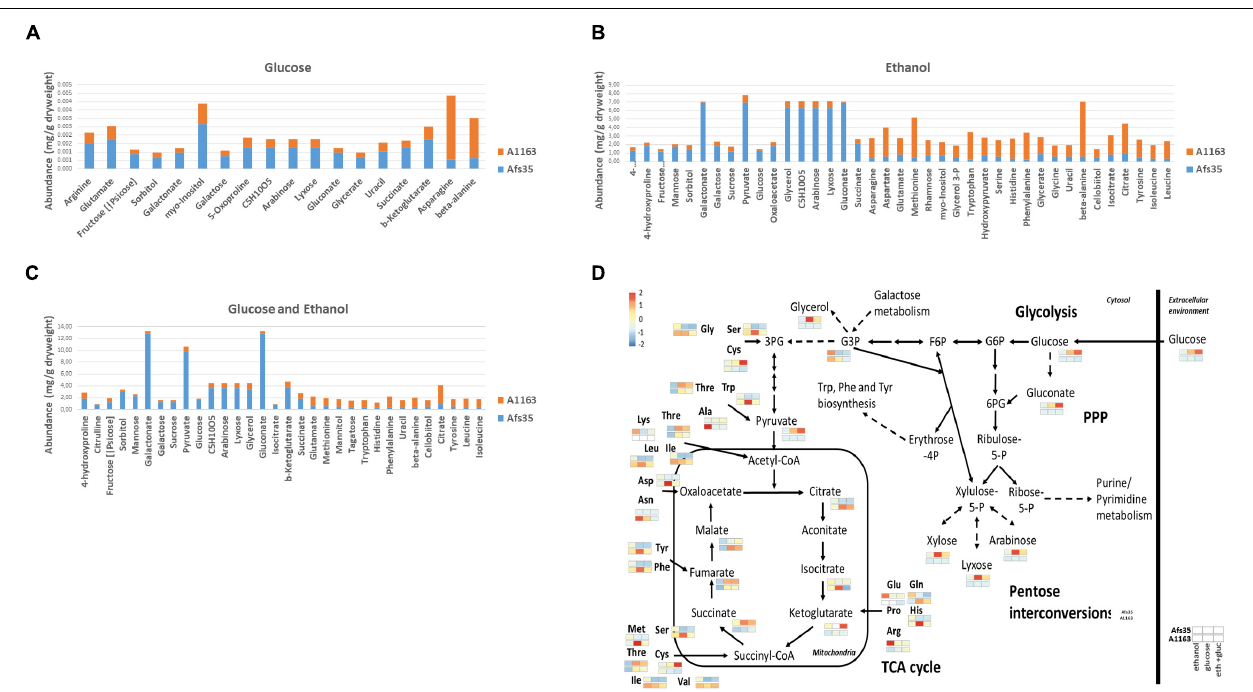
FIGURE 3 | Strain Afs35 is metabolically different from strain A1163. (A–C) Abundance (the value of each replicate was divided by the median of the given metabolite) of quantitatively significant different metabolites from five biological replicates identified in both strains when grown for 16 h in minimal medium (MM) supplemented with glucose, ethanol or glucose and ethanol. (D) Diagram of metabolites of the central carbon metabolic pathways glycolysis, citric acid cycle and pentose phosphate pathway. Shown is the relative abundance of metabolites from five biological replicates, in the form of a heat map, identified in strains Afs35 and A1163 in each of the aforementioned